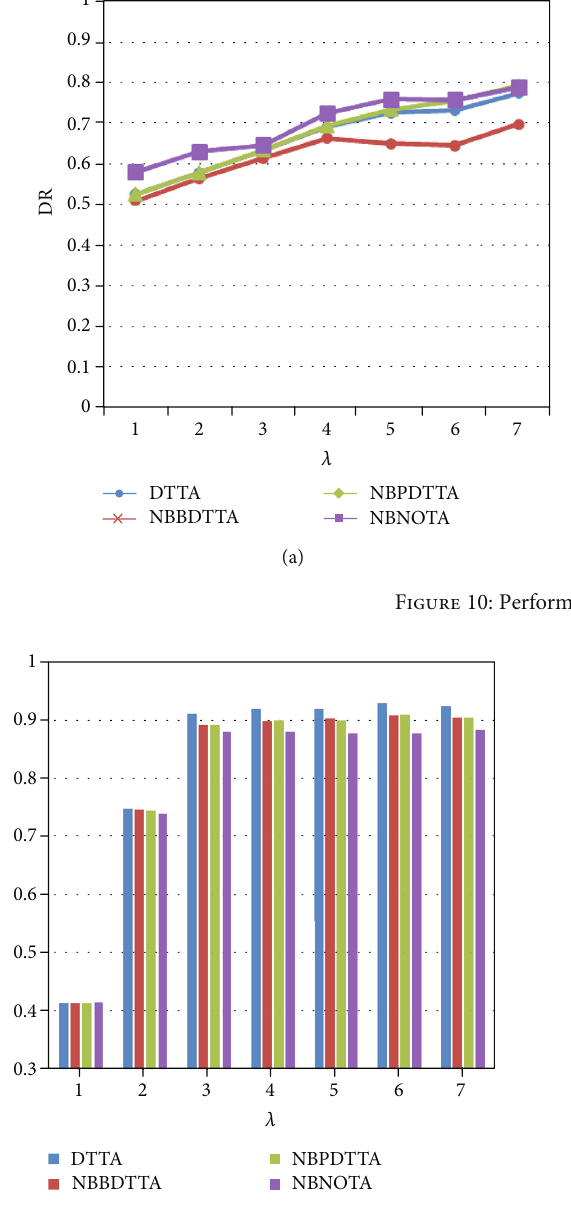
Figure 11: Performance impact of a . Figure